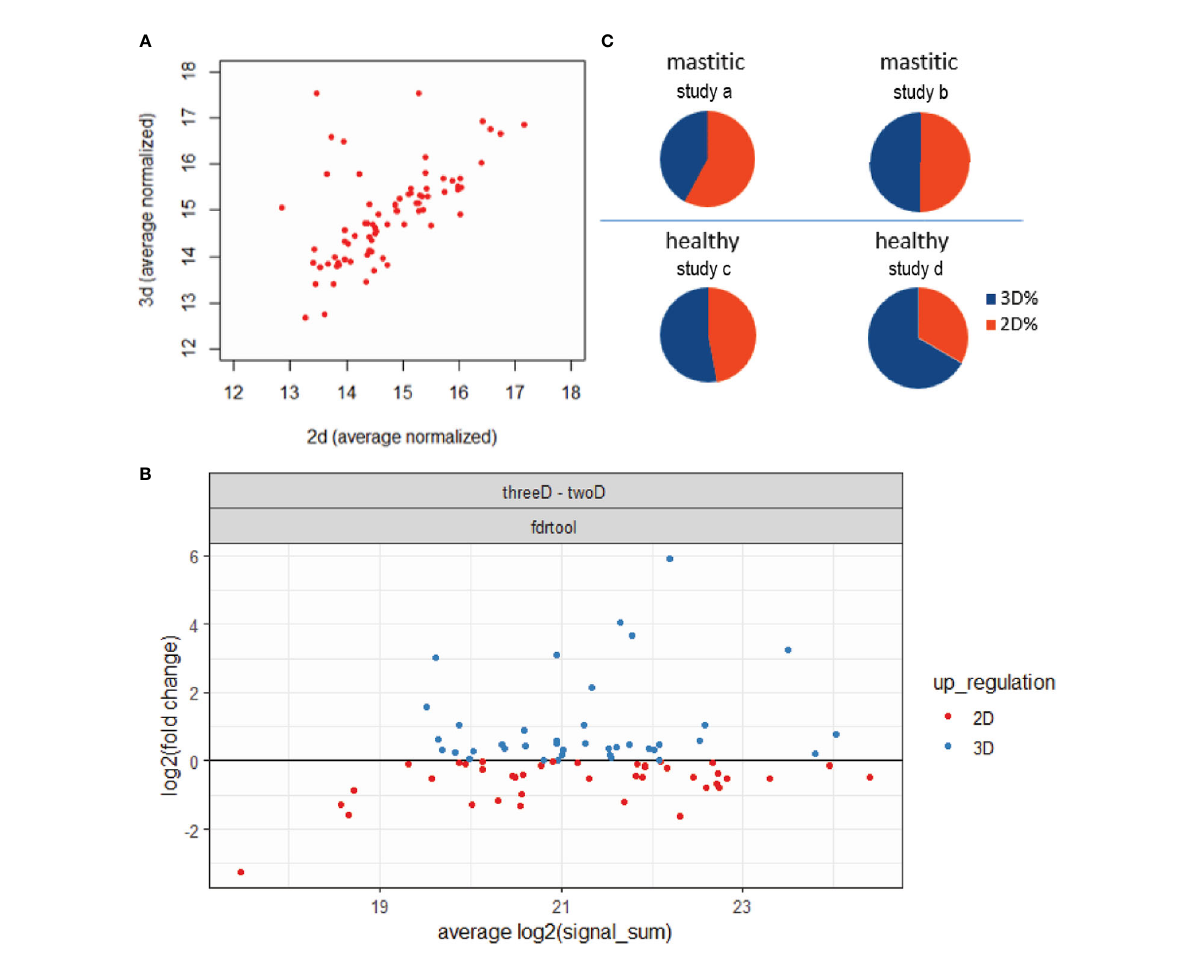
FIGURE 3 Comparison of the proteins identi fi ed by the 2D and 3D models. (A) Normalized signal for the 79 identi fi ed proteins for both models. (B) Fold- change of the signal of the 79 identi fi ed proteins between the two models against the total signal of each protein. With red are shown the proteins with higher signal in the 2D model and with blue the proteins with higher signal in the 3D model. (C) Ratios of common proteins between 2D and 3D overrepresented proteins and two studies regarding healthy milk from (Cunsolo et al., 2017;study a) and (Zhang et al., 2020; study b) or two studies regarding mastitic milk from (Addis et al., 2013; study c) and (Chiaradia et al., 2013; study